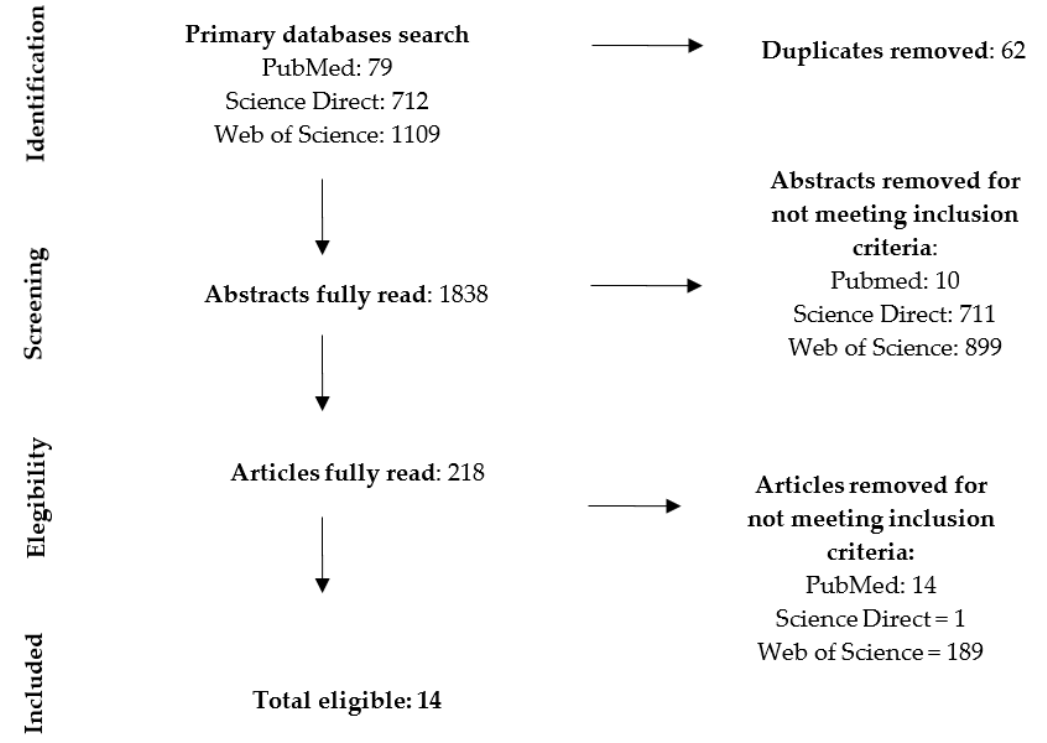
Figure 1. Workflow of article search (PRISMA 2009 Flow Diagram [20]). Table 1. Articles included in the review.